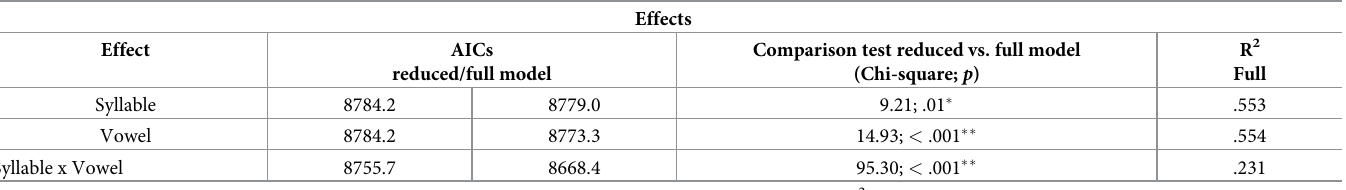
Table 7. Effects on F 3 (in Hz) at the midpoint of the steady state.